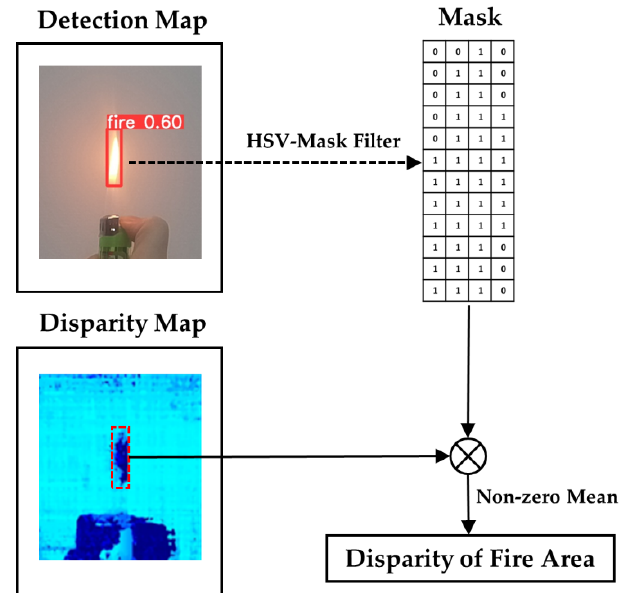
Figure 9. The flow chart of HSV-Mask Filter. The detected bounding box is transformed into a mask matrix by HSV-Mask filter, and then multiplied by the corresponding disparity matrix. Finally, the non-zero mean is calculated to get the disparity value of the fire area.